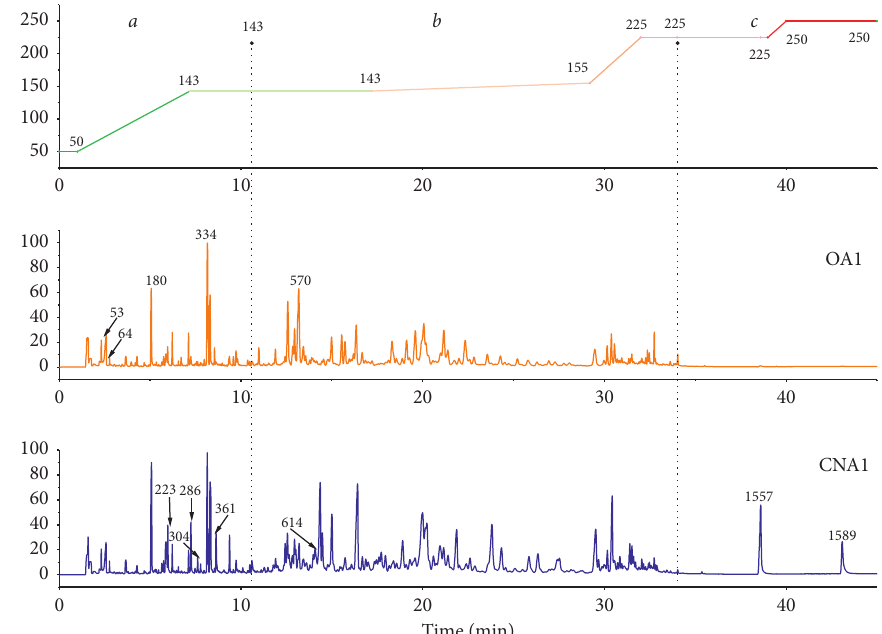
Figure 3: The total ion chromatograms of typical agarwood samples (OA1 and CNA1) acquired by SHS-GC-MS and the corresponding temperature gradientvariety diagram ( a zone: 0–10.6 min; b zone: 10.6–34.0min; c zone: 34.0–45min).